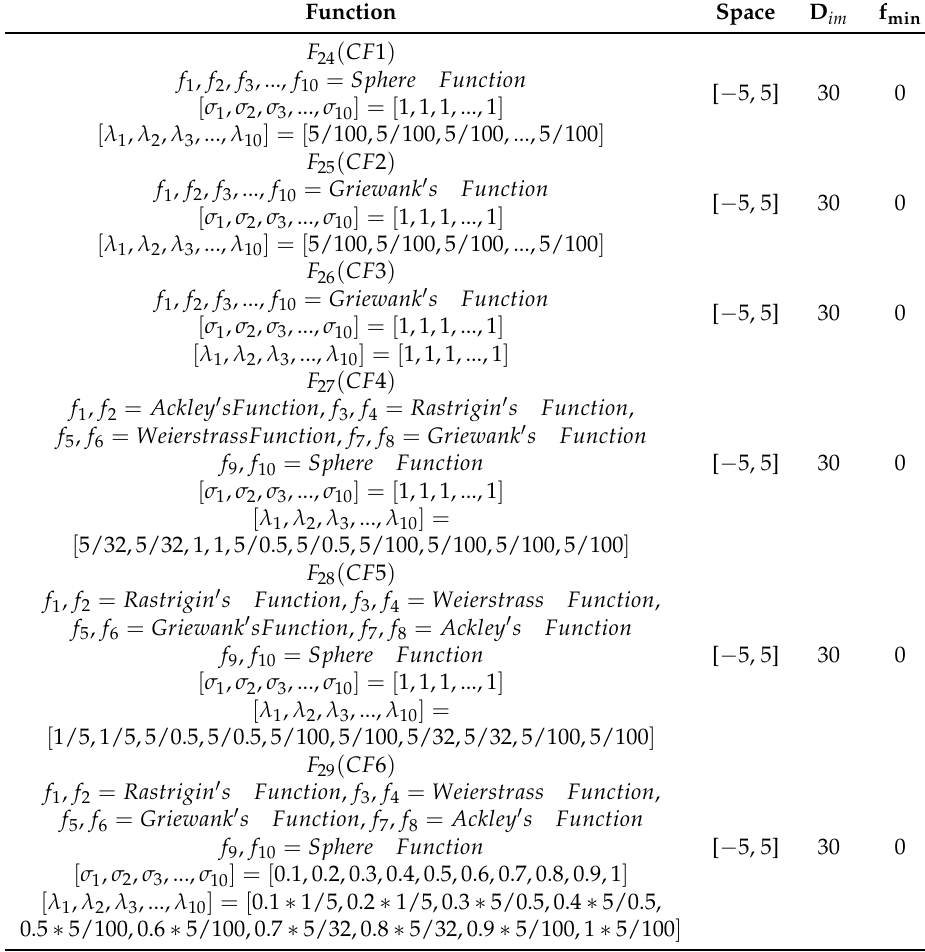
Table 4. Composite multimodal benchmark functions.